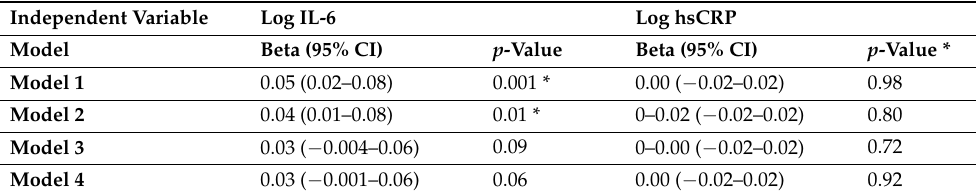
Table 2. Linear regression of the association of inflammatory markers (logIL-6 and log hsCRP) and apathy N = 347.